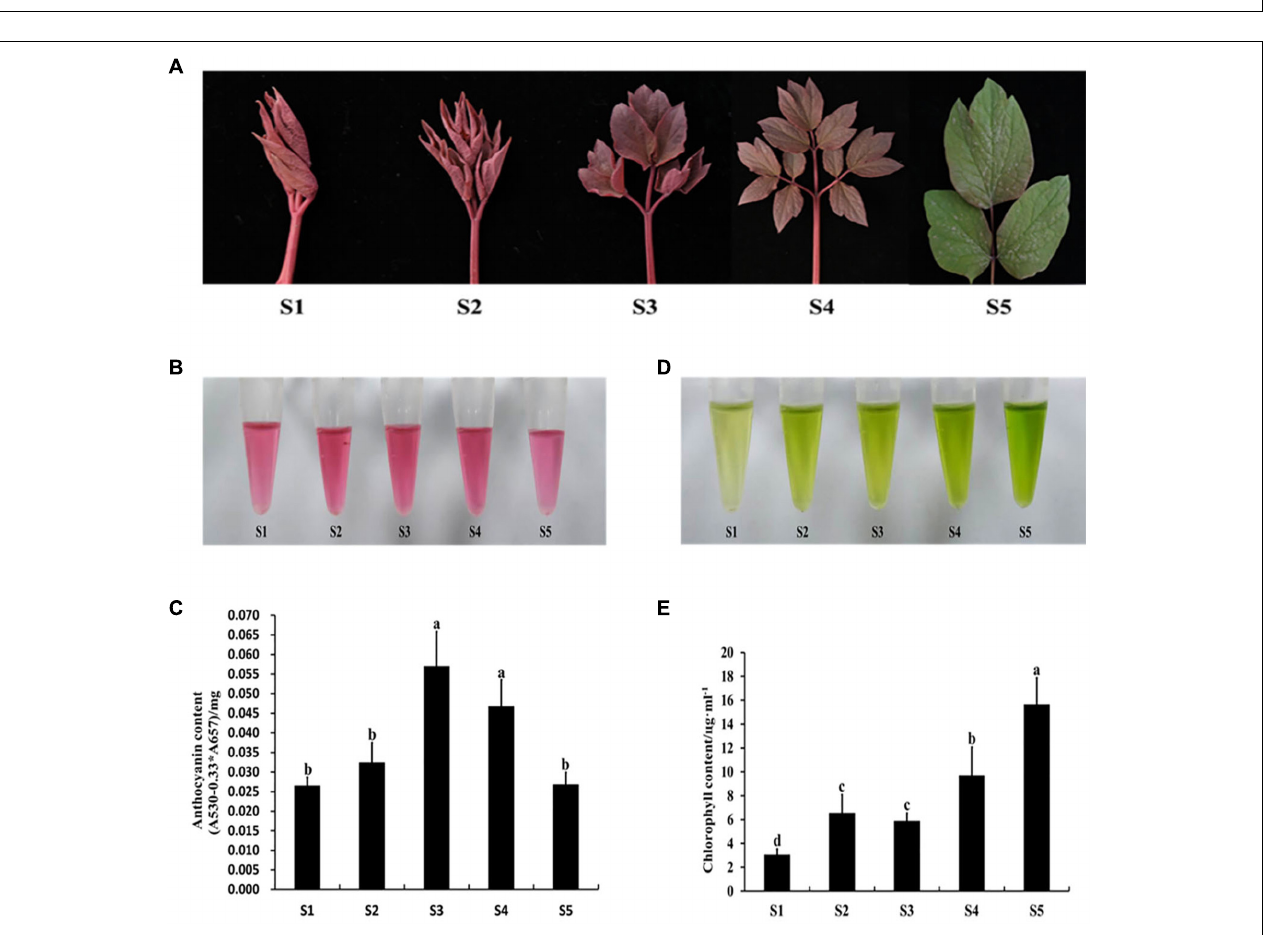
FIGURE 1 | Phylogenetic analysis and sequence alignment of PqMYB113. (A) The phylogenetic analysis of PqMYB113 protein and MYB proteins from other species. PqMYB113 is highlighted with a red dot. The neighbor-joining method with MEGA software was used to construct the phylogenetic tree. Bootstrap values as a percentage of 1000 replicates are indicated at corresponding branch nodes. Putative functions of the R2R3-MYBs are listed on the right. (B) The alignment of deduced amino acid sequences of PqMYB113 with other similar R2R3-MYB proteins. Alignment was conducted using DNAMAN Version 8. The R2 (black line) and R3 (yellow line) MYB domains shown refer to two repeats of the MYB DNA-binding domain of MYB proteins. The blue box shows the motif that interacts with bHLHs. The red and black boxes show the ANDV motif and motif 6, respectively.